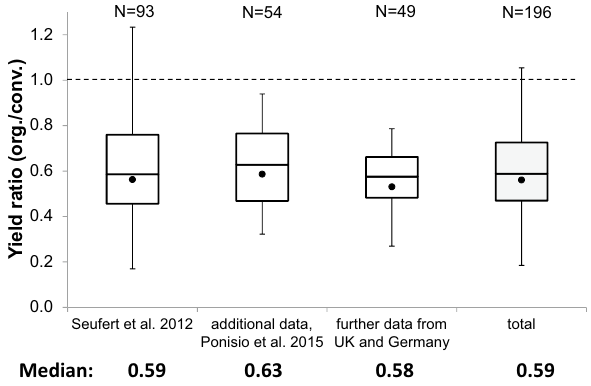
Figure 1. The wheat yield gap. Ratio of organic to conventional wheat yields (O:C ratio) from various data sources. Quartiles (box), mean (filled circle), 2%- and 98%-percentile (whiskers); absolute maximum (1.76) and minimum (0.13) not shown; number of observation pairs given at top. The second box shows data compiled by Ponisio et al. 11 that was not included in the meta-analysis by Seufert et al. 10 . Further data not included in either study is shown in the third box.